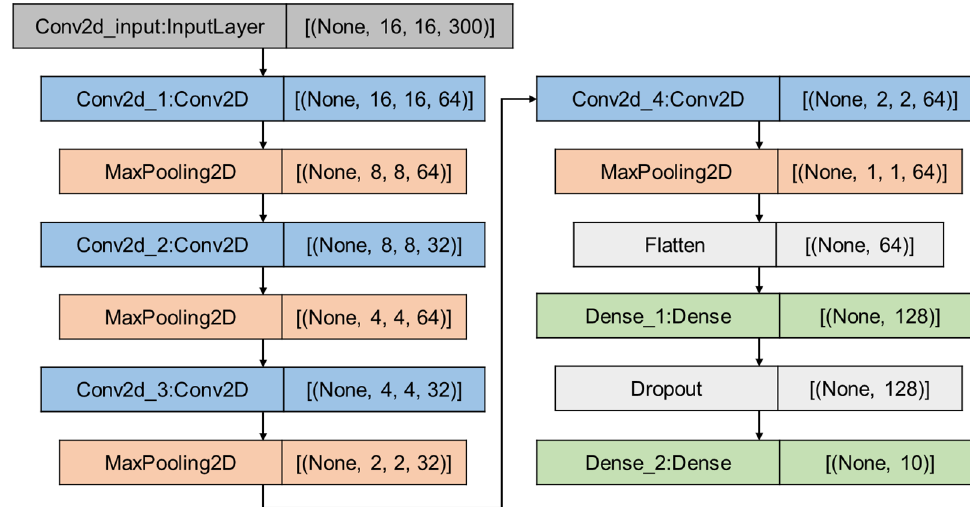
Figure 6. CNN architecture used in this study.